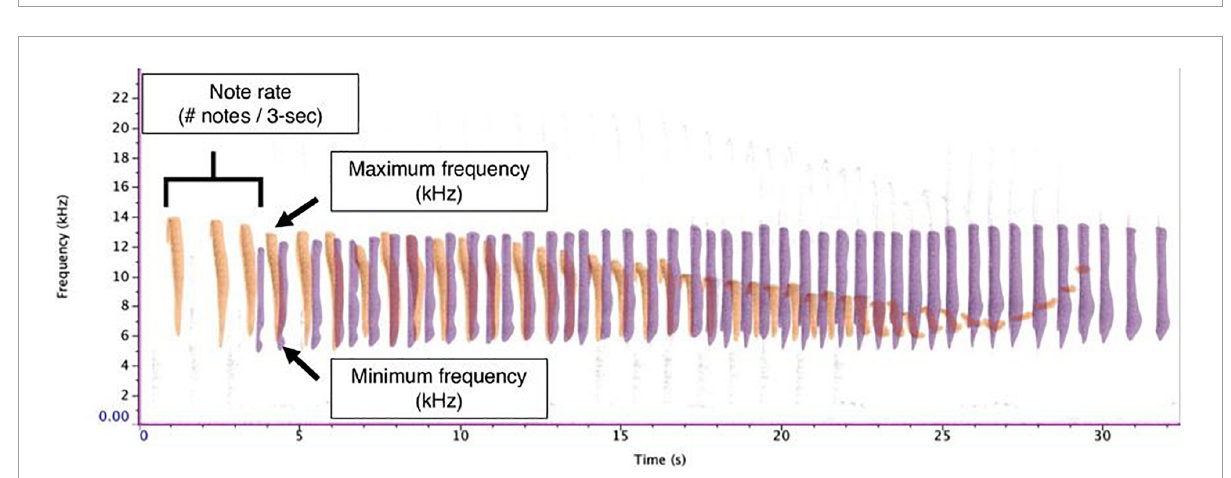
FIGURE3 Exemplar of male and female duet contributions and analyzed features. The male duet contribution is shown in purple, and the female duet contribution is shown in orange. Note rate was calculated as the number of notes per 3-s interval. Note bandwidth was determined by subtracting the minimum frequency from the maximum